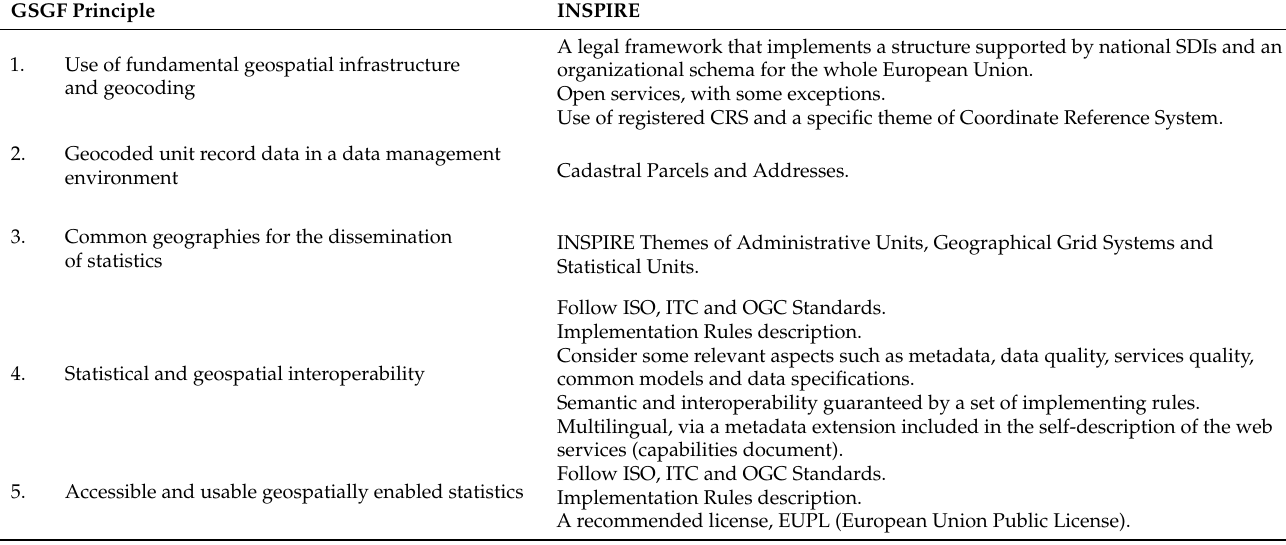
Table 1. Relationship between GSGF Principles and